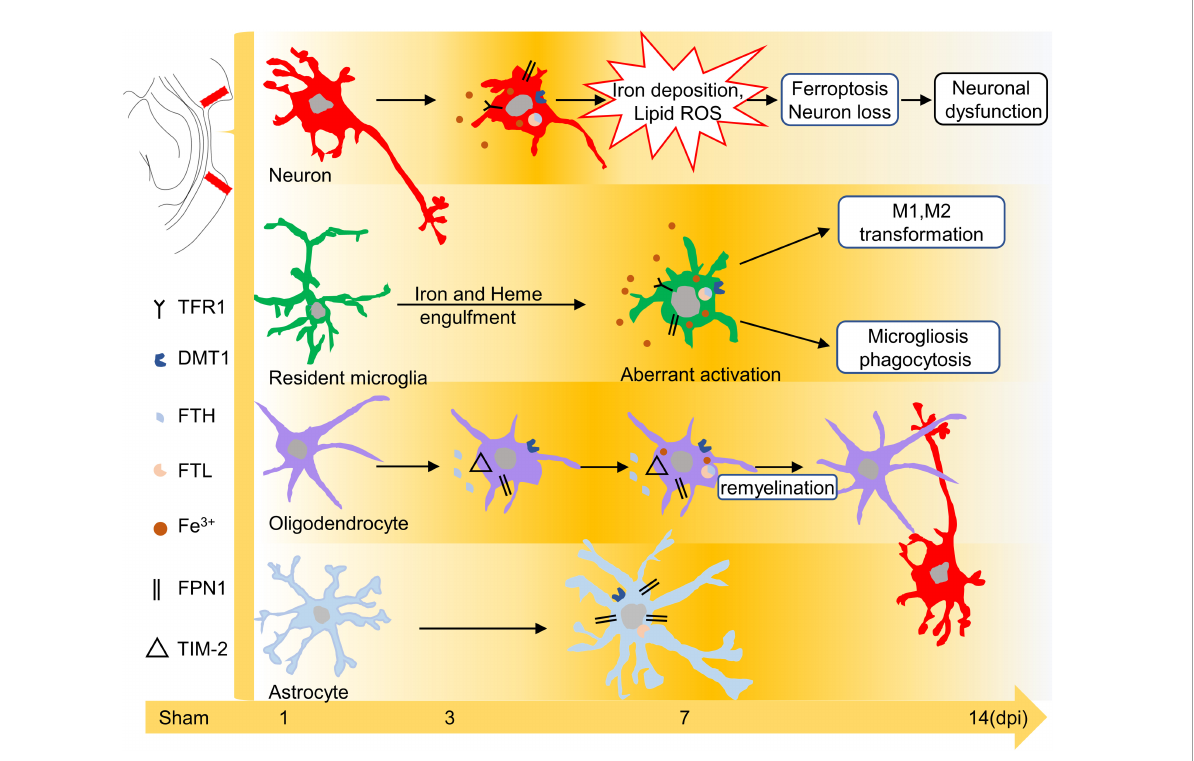
FIGURE7 Schematic diagram of the effect of iron or iron metabolism on neurons and glial cells. Iron plays different roles in neurons and glial cells after TBI. Excess iron induces oxidative damage and ferroptosis in neurons during the early phase of TBI. Iron may lead to microglial polarization and microgliosis. In addition, iron overload is likely related to the repair of oligodendrocytes at 7–14 dpi, whereas peroxidative damage in astrocytes is iron-independent. TBI, traumatic brain injury; dpi, days